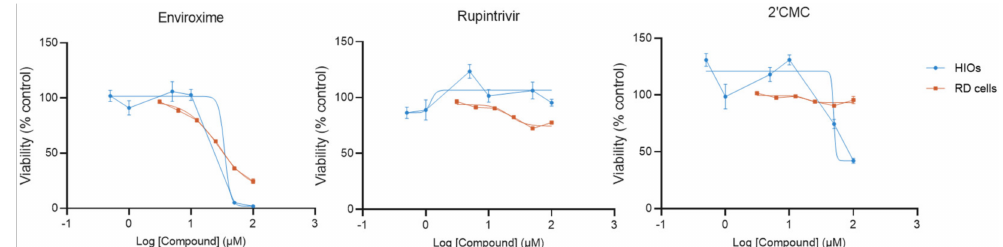
Figure 3. Compounds’ cytoxicity in HIOs and RD cells. To measure the viability of HIOs and RD cells, Cell Titer-Glo 3D and Cell Titer-Glo, respectively, were used 72 h post-treatment. DMSO control was used to normalize the viability as a percentage. The half maximal cytotoxic concentration (CC 50 ) was calculated using Prism nonlinear regression (GraphPad Prism 9). Data are the mean ± SEM of at least four independent experiments, each carried out in